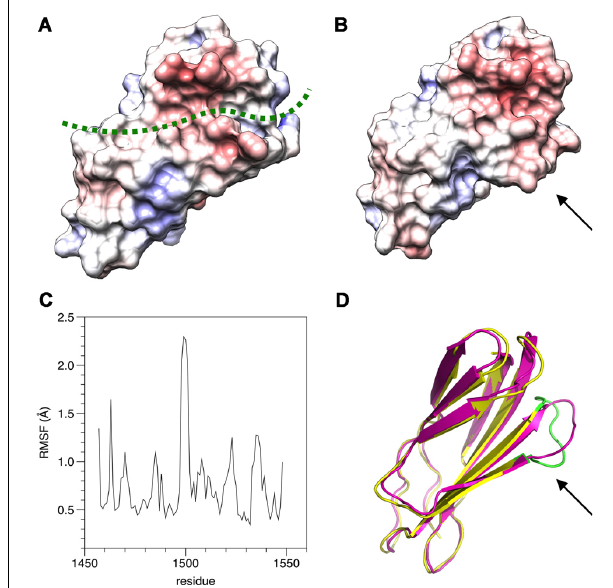
FIGURE 6 | Possible binding site for L-PRX. (A) Surface of the β 4-FNIII-3 crystal structure, colored by electrostatic potential. The predicted binding site is shown by a green dashed line. (B) MD simulation indicates the possible binding site is flexible (arrow) and may open up more. (C) RMSF during the 550-ns simulation. (D) Comparison of the start (magenta) and end (yellow/green) points of the simulation. The loop at the potential binding site (arrow) is the most mobile region. The largest peak in the RMSF plot (panel C ) is colored green in the post-simulation structure.